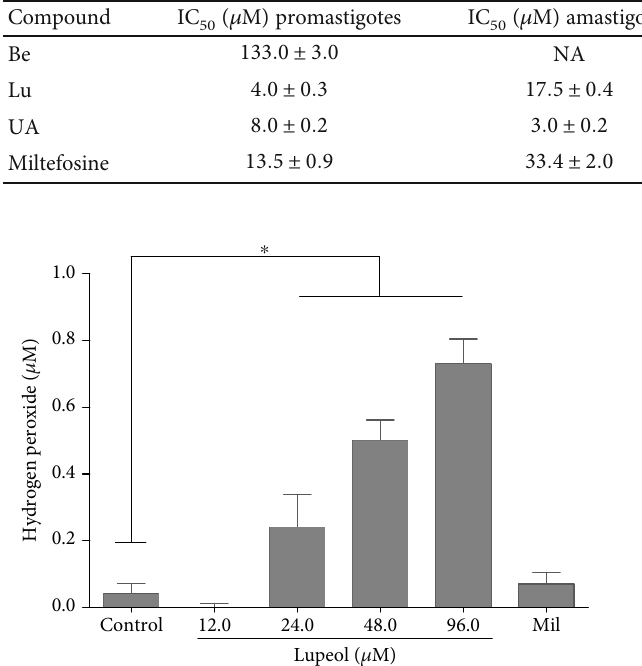
Figure 1: Hydrogen peroxide production. Macrophages infected with L. ( L. ) infantum were incubated with di ff erent concentrations of betulin (Be), lupeol (Lu), ursolic acid (UA), and miltefosine. After 24h, the supernatants were collected and the NO and H levels were quanti fi ed. Only infected macrophages treated with Lu O . ∗ p < 0 : 05 compared to produced H 2 2